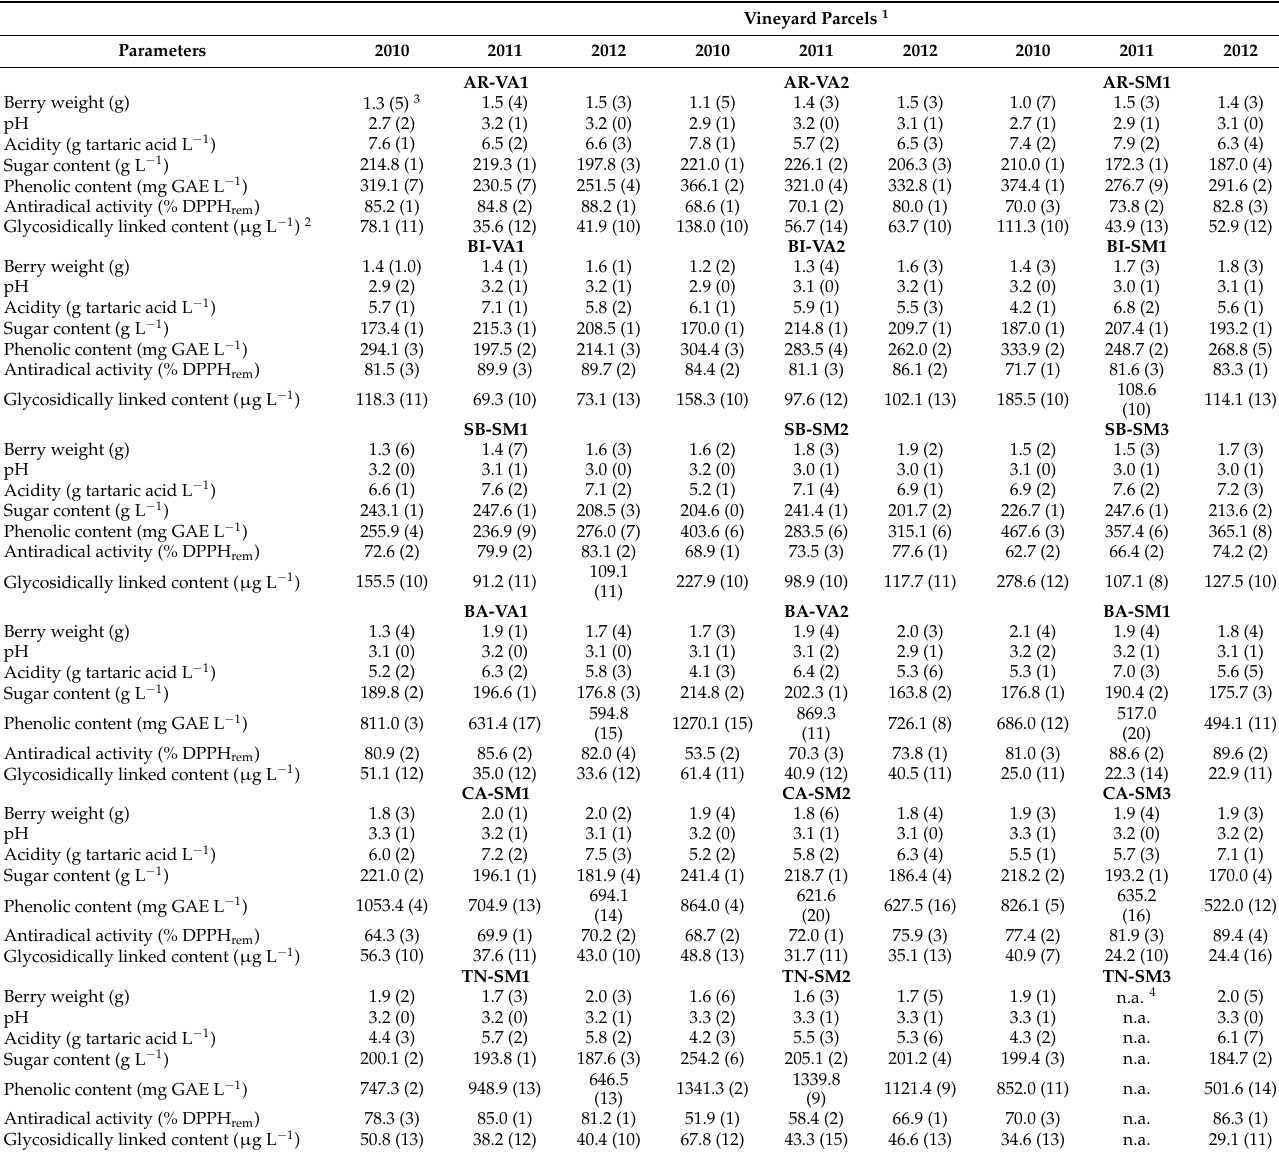
Table 2. Synoptic table of the physicochemical and glycosidically linked content of V. vinifera cv. Arinto (AR), Bical (BI), Sauvignon Blanc (SB), Baga (BA), Castel ã o (CA), and Touriga Nacional (TN) grapes, each one from three harvests and three vineyard